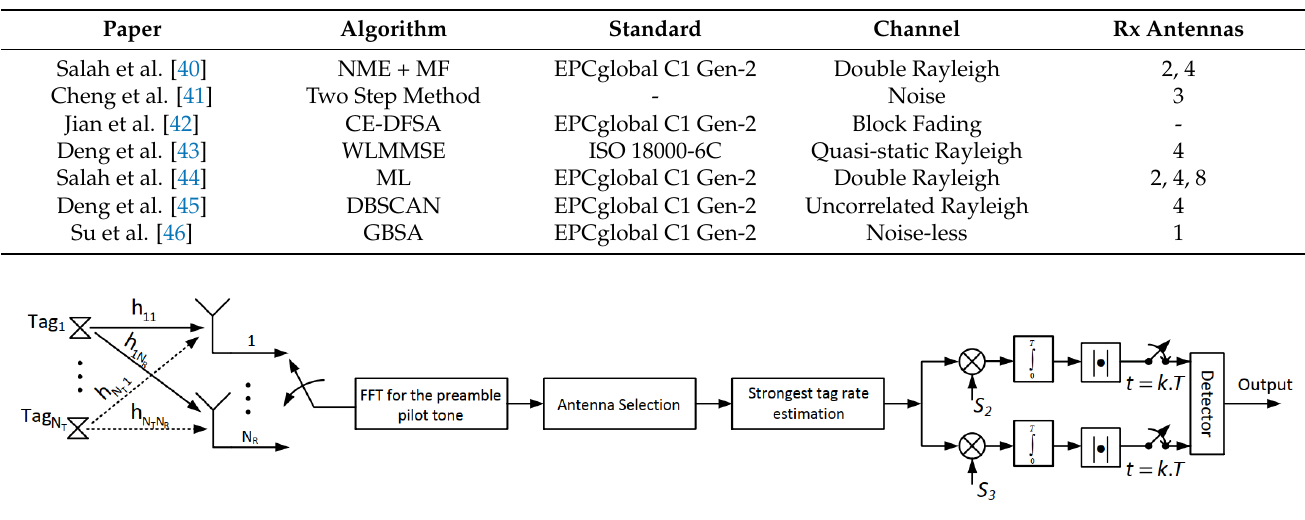
Table 2. Comparison of various anti-collision techniques.